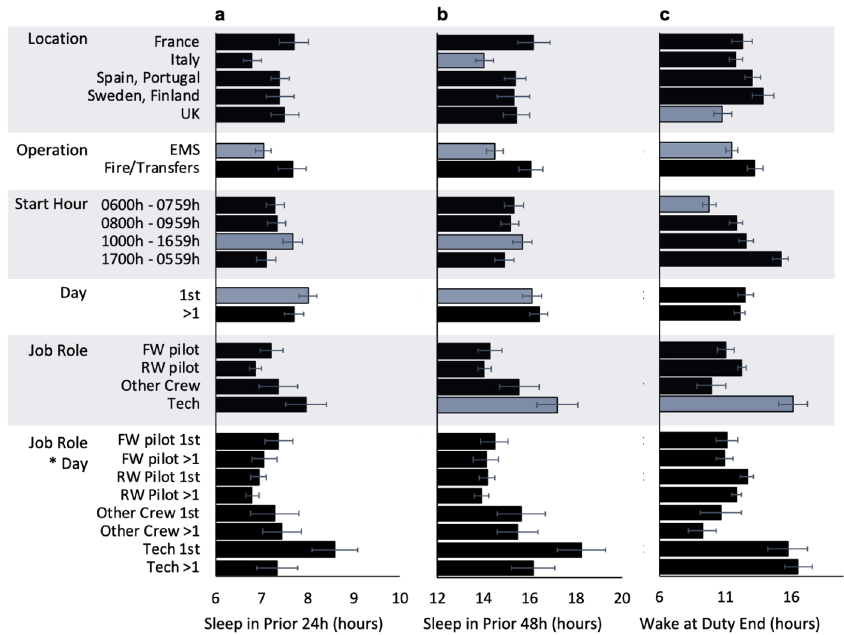
Figure 5. Sleep prior to duty and wake at duty end varies as a function of location, type of operation, shift start hour, consecutive days into duty, and job role. Figure displays estimated marginal means (bars) and their standard errors (whiskers) from the models conducted to examine differences in sleep in the 24 h (panel a ) and sleep in the 48 h (panel b ) prior to starting a duty period, and wake time at the end of duty (panel c ) by work- related factors. Blue bars indicate significant differences from other levels of that variable, p < 0.05. Note: EMS = Emergency Medical Service, Fire = Firefighting, Transfers = Air Taxi, SAR = Search and Rescue, FW = Fixed Wing, RW = Rotary Wing, Tech =